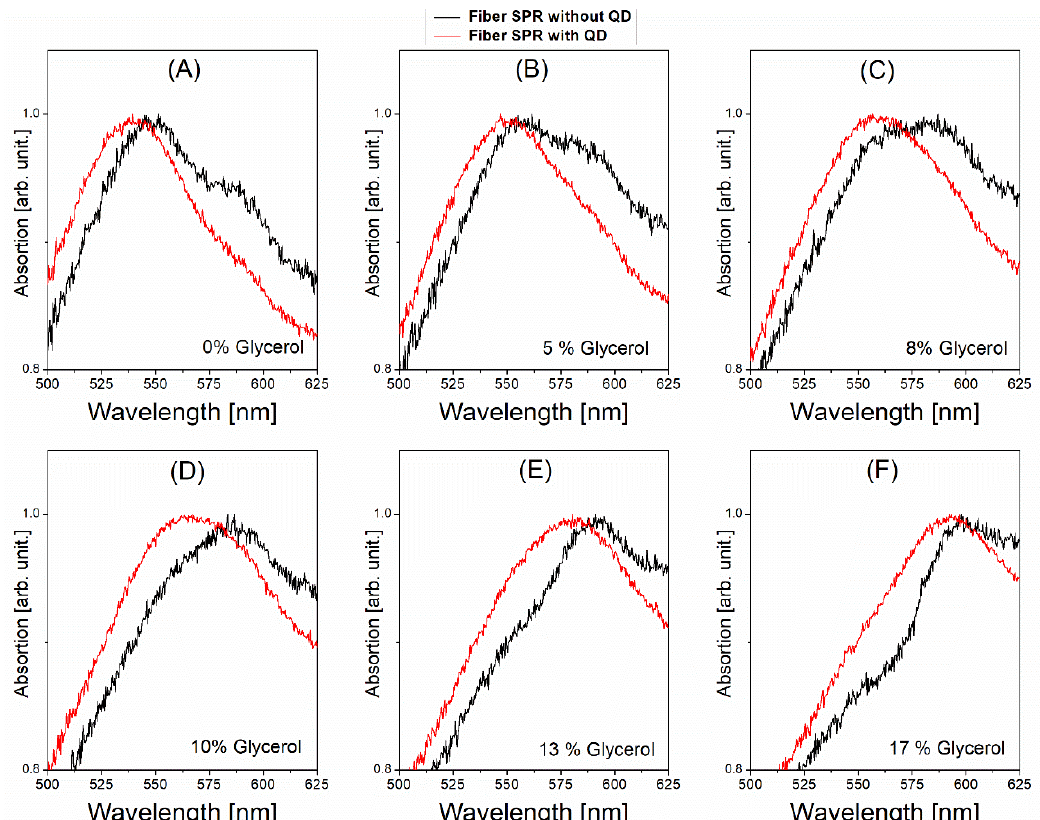
Figure 4. Fiber-based plasmonic absorption spectra at various concentrations of glycerol solution, ( A ) 0% ( B ) 5% ( C ) 8% ( D ) 10% ( E ) 13% ( F ) 17%. Black and red curves represent cases without and with QDs anchored on the outermost metal (Au) surface, respectively. The fiber incident optical power is 3.8 mW.